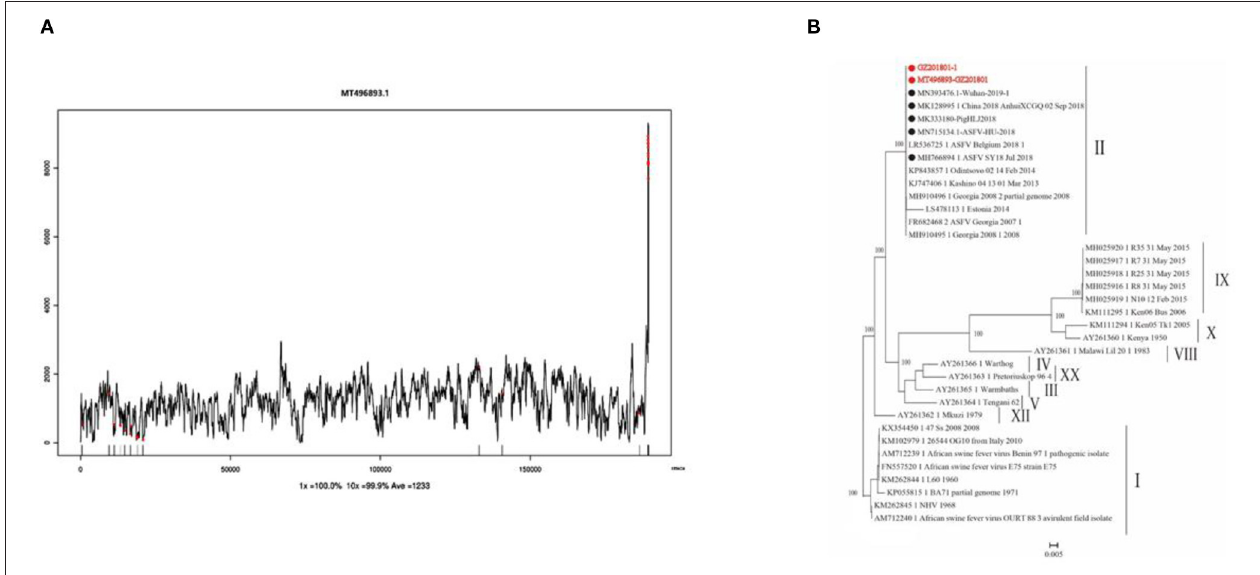
FIGURE 8 | Sequencing depth map and genome-wide phylogenetic tree. (A) Sequencing depth map of African swine fever virus. (B) Genome-wide phylogenetic tree of the GZ201801